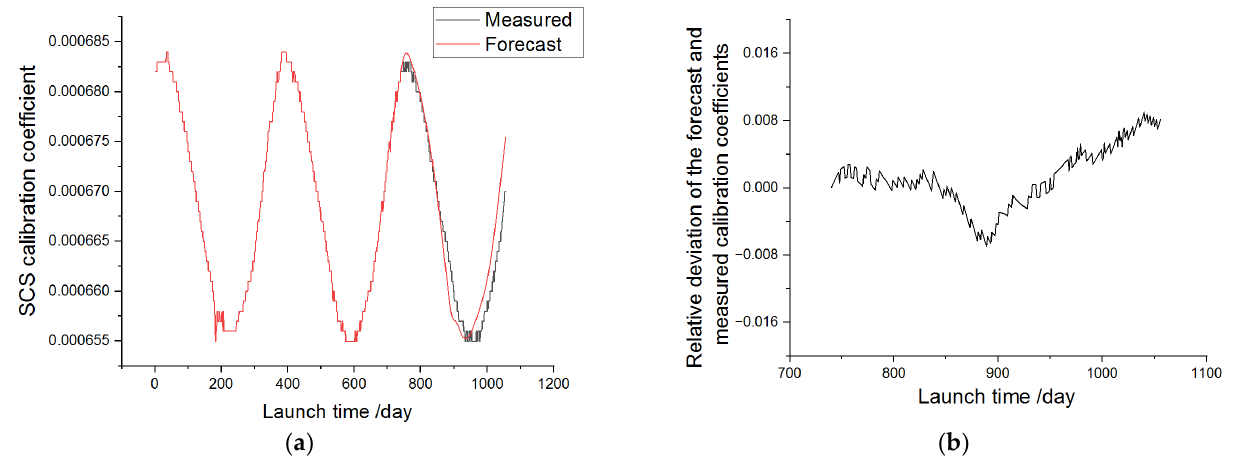
Figure 13. Calibration coefficients forecast accuracy using LSTM. ( a ) Comparisons of forecast data and measured data and ( b ) relative deviation of forecast data and measured data.